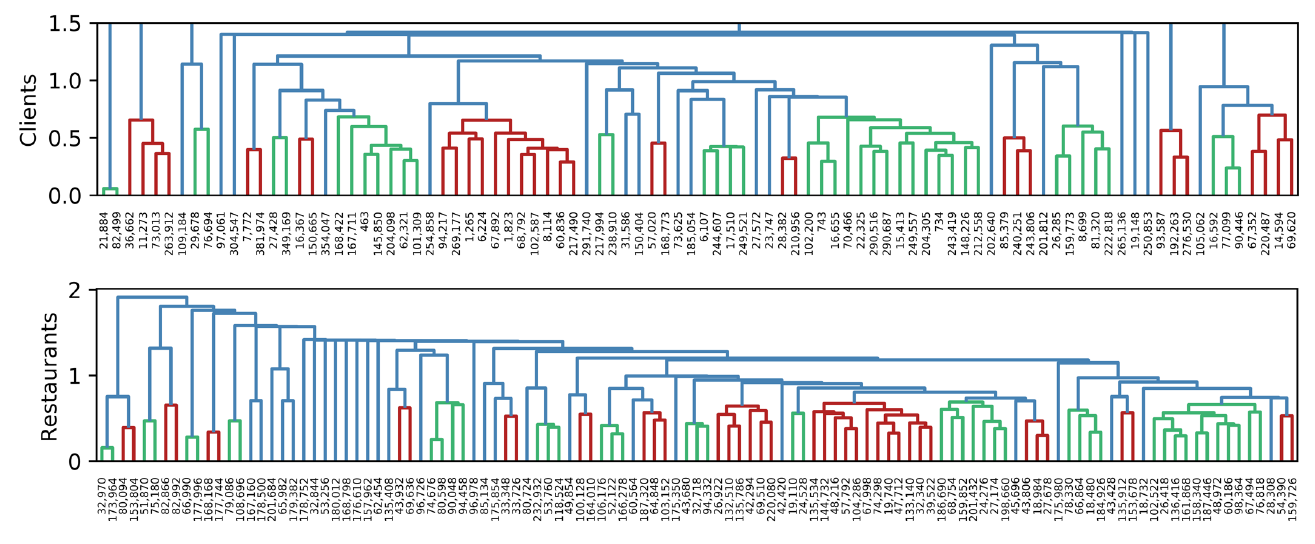
Figure 5. Similarity among clients and restaurants in 2021. The length of vertical lines represents the distance between items. The shorter the line, the closer the items. Different colors represent possible groups of items.